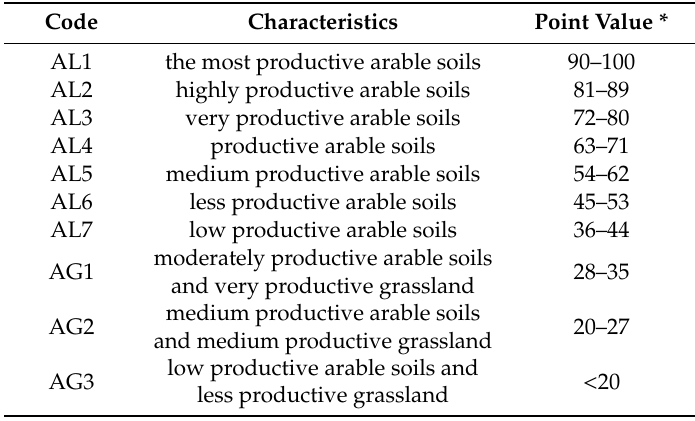
Table 2. Productive categories of arable soils in Slovakia